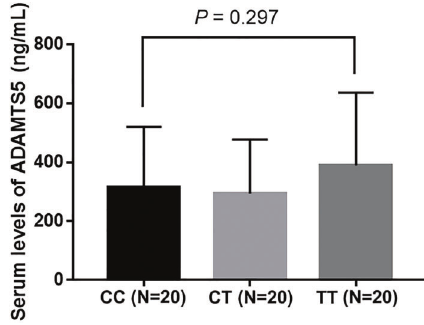
Figure 4. Histogram of serum ADAMTS5 levels in patients with OA. Data are reported as means ± SD ( t